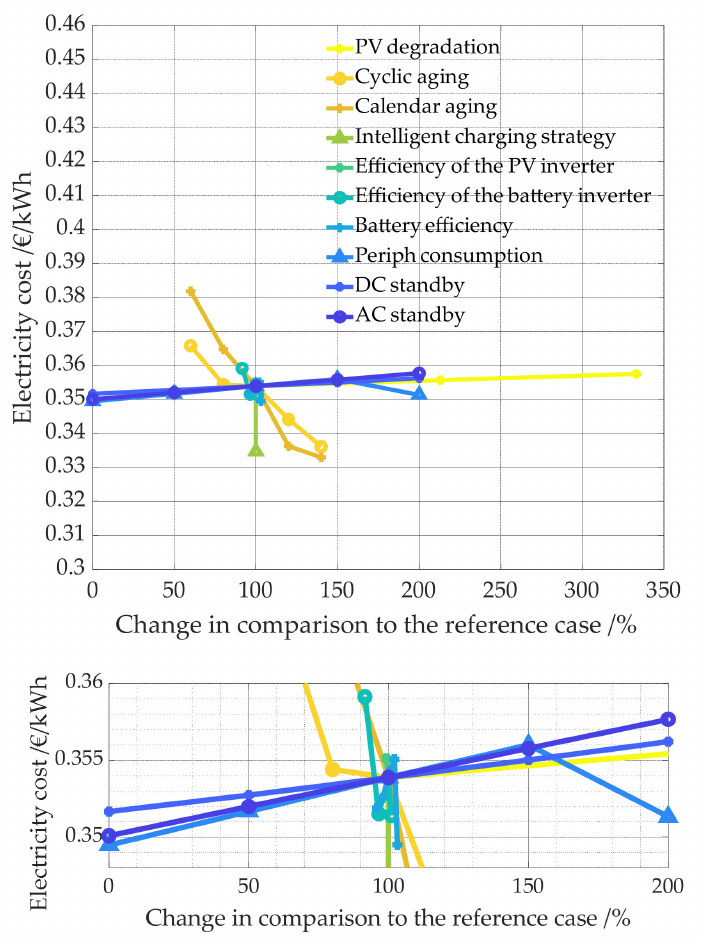
Figure 31. PV system battery combination of 5 kWp and 5 kWh. While the upper figures show all data points, the lower figures show only parts of the data in order to better illustrate even small changes in relation to the reference